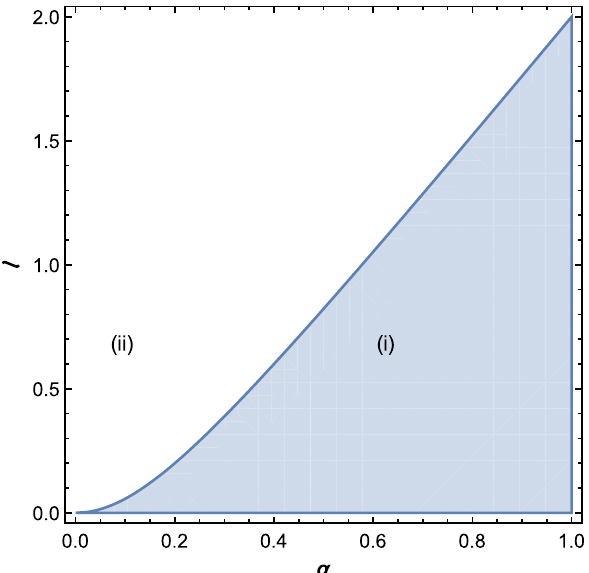
Fig. 2 Allowed values of α e l regarding conditions (i) and